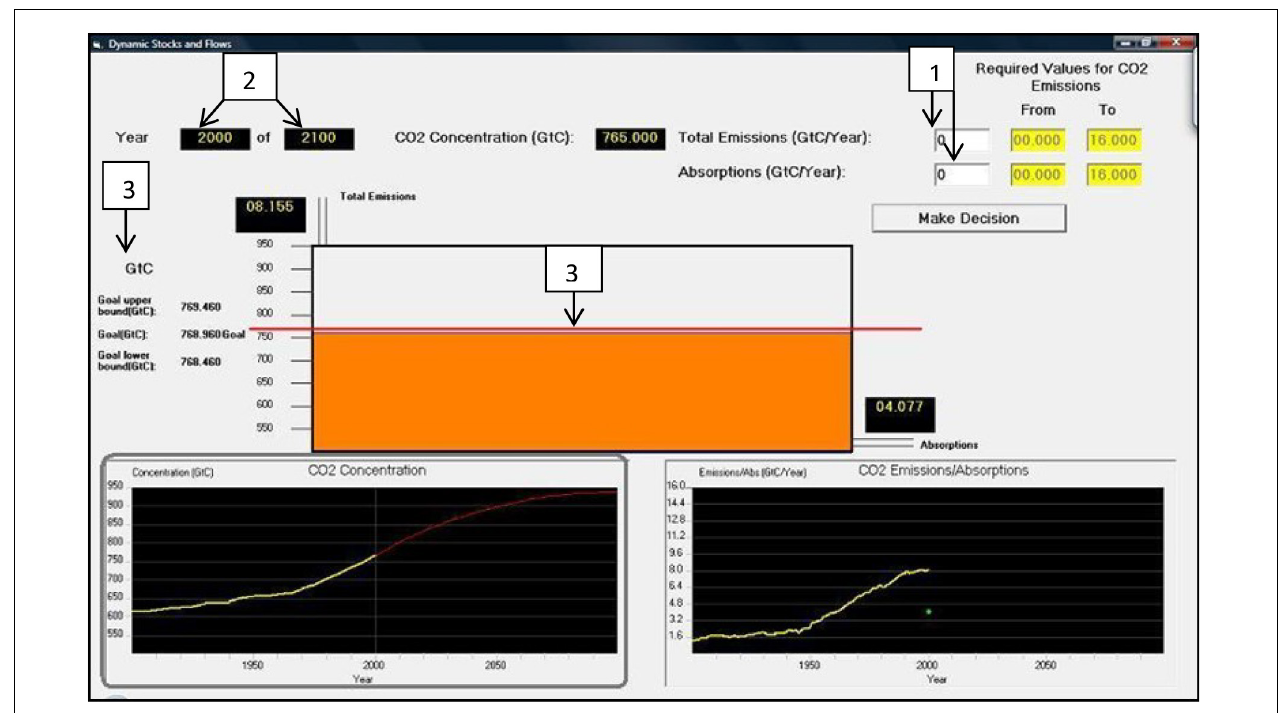
FIGURE 2 | The Dynamic Climate Change Simulator (DCCS) task. DCCS is a dynamic replica of the CS task. (1) Participants set yearly CO 2 emissions and absorptions and press “Make Decision” button. (2) The system now moves forward a certain number of years. (3) Participants need to maintain their CO 2 concentration at the red goal line in the tank (which represents the atmosphere) and follow the CO 2 concentration trajectory shown in the bottom left panel (Source: Dutt and Gonzalez, 2012a).